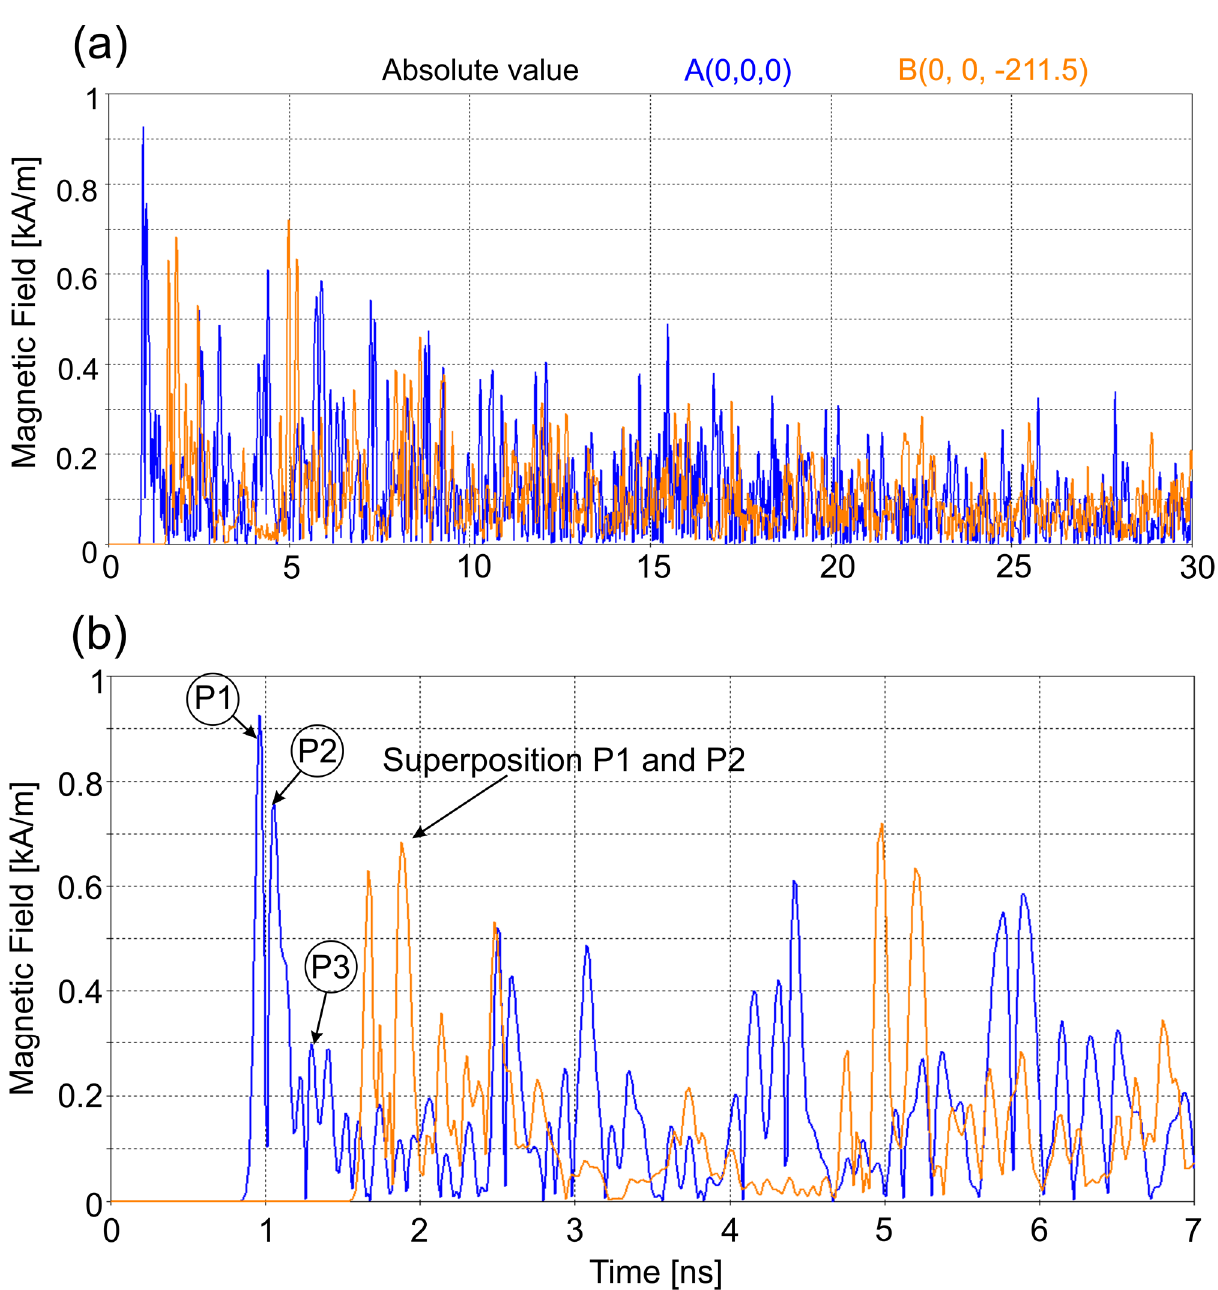
Figure 8. Time-dependence of the magnetic field strength amplitude at points: A (0, 0, 0) and B (0, 0, − 211.5) in the shielding enclosure with aperture after the interference of the subnanosecond high-energy EM pulse over 0–30 ns ( a ) and 0–7 ns ( b ) the internal magnetic field pulses at points A and B. The pulses labeled P1, P2, and P3 (in circles) resulted from the passages of the corresponding primary waves through points A and B. The pulses labeled “Superposition P1 and P2” resulted from the constructive interference of the primary waves P1 and P2 moving in opposite directions. Note that the internal magnetic field pulses have a duration of subnanoseconds.